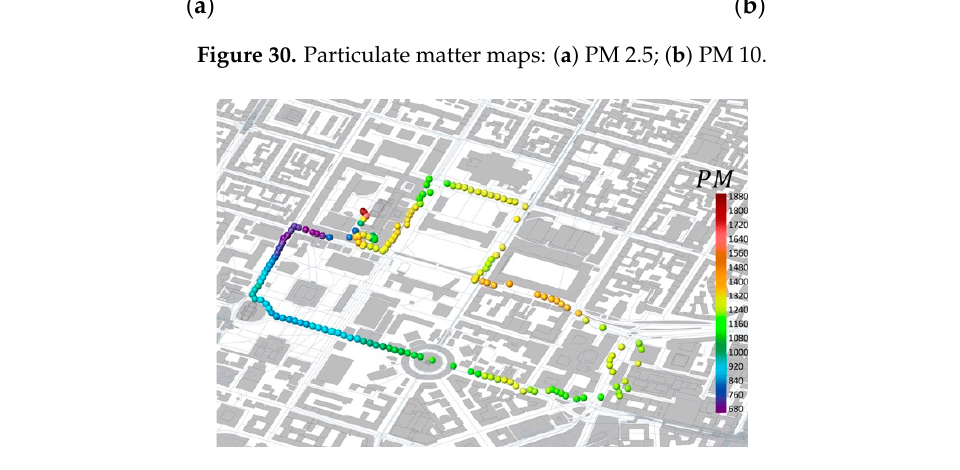
Figure 31. Map for detected particles >0.3 micrometer/0.1 L.